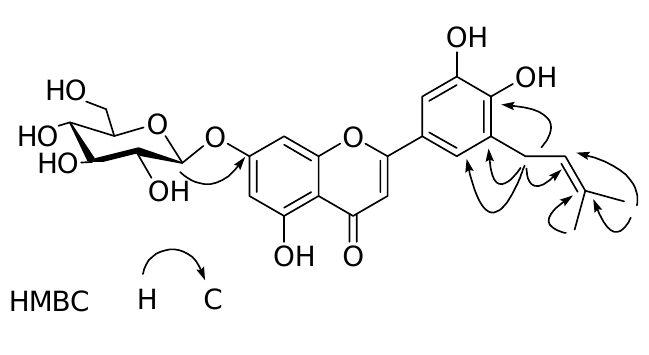
Figure 2. Key HMBC correlations of 2